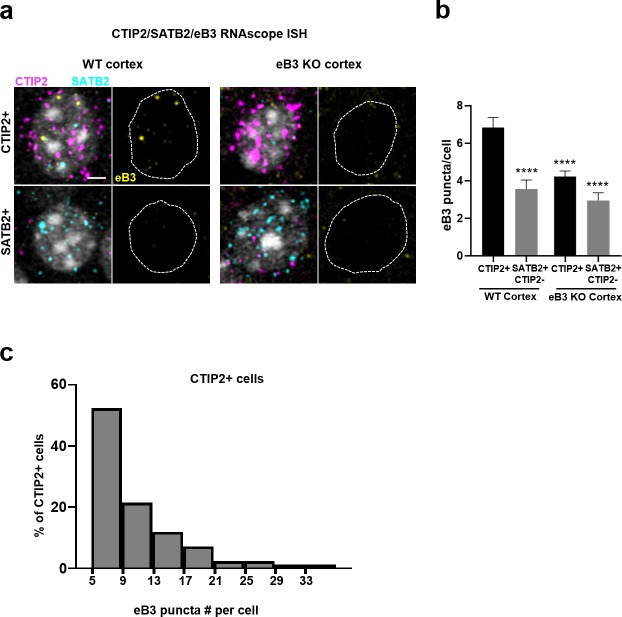
Controls for RNAscope ISH.(a) Representative three color RNAscope ISH images from WT and Efnb3-/- mouse cortex, showing reduced eB3 probe signal in CTIP2 + cells (CTIP2 + and CTIP2+/SATB2 + included) within Efnb3-/- cortex. Scale bar, 3 µm. (b) Quantification of Efnb3 expression in the indicated cell types in WT and Efnb3-/- cortex (WT CTIP2+, n = 141; WT SATB2+, n = 93; KO CTIP2+, n = 236; KO SATB2+, n = 86 F (3, 552)=14.39, p<0.0001, one-way ANOVA, ****p<0.0001, Tukey’s post hoc). (c) Distribution of Efnb3 puncta numbers in CTIP2 + cells (N = 84, bin size = 4). Cells with less than five puncta were excluded.10.7554/eLife.41563.020Figure 5—figure supplement 2—source data 1.Controls for RNAscope ISH.